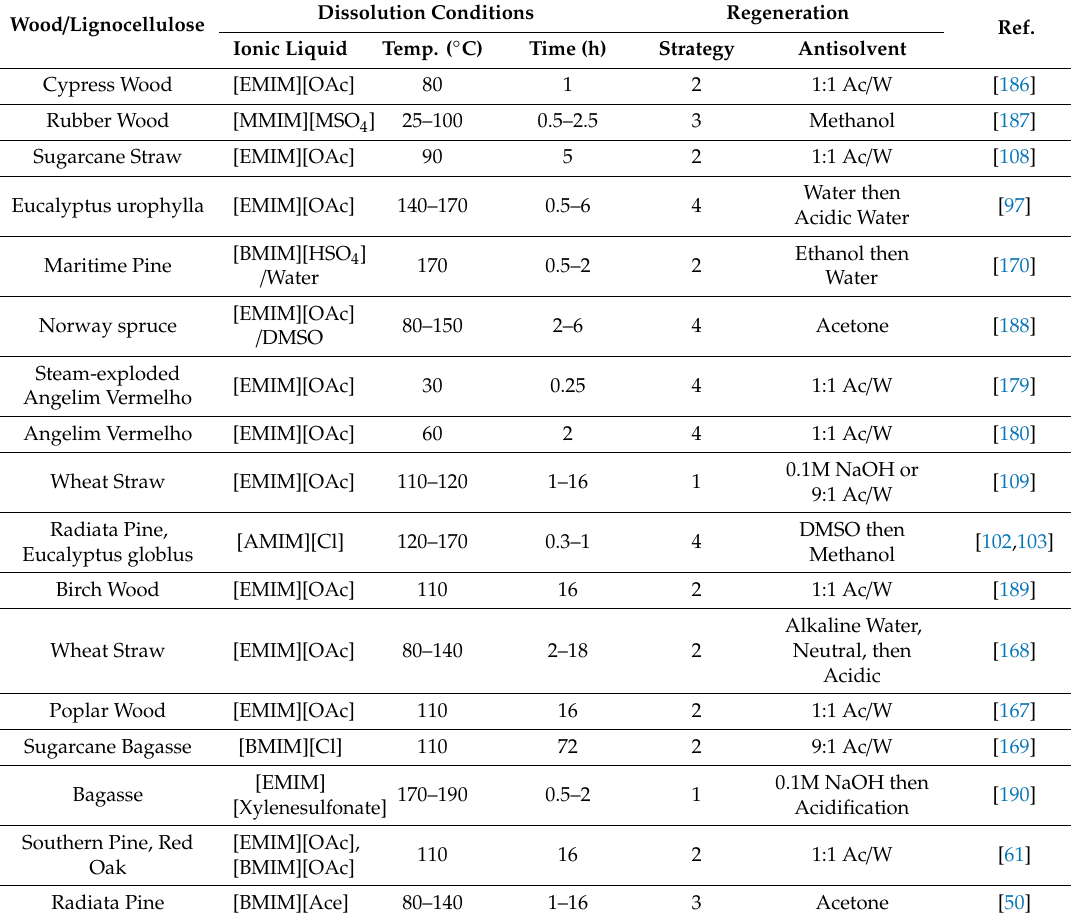
Table 3. Summary of the literature on wood fractionation for the separation of its individual polymers. Wood /